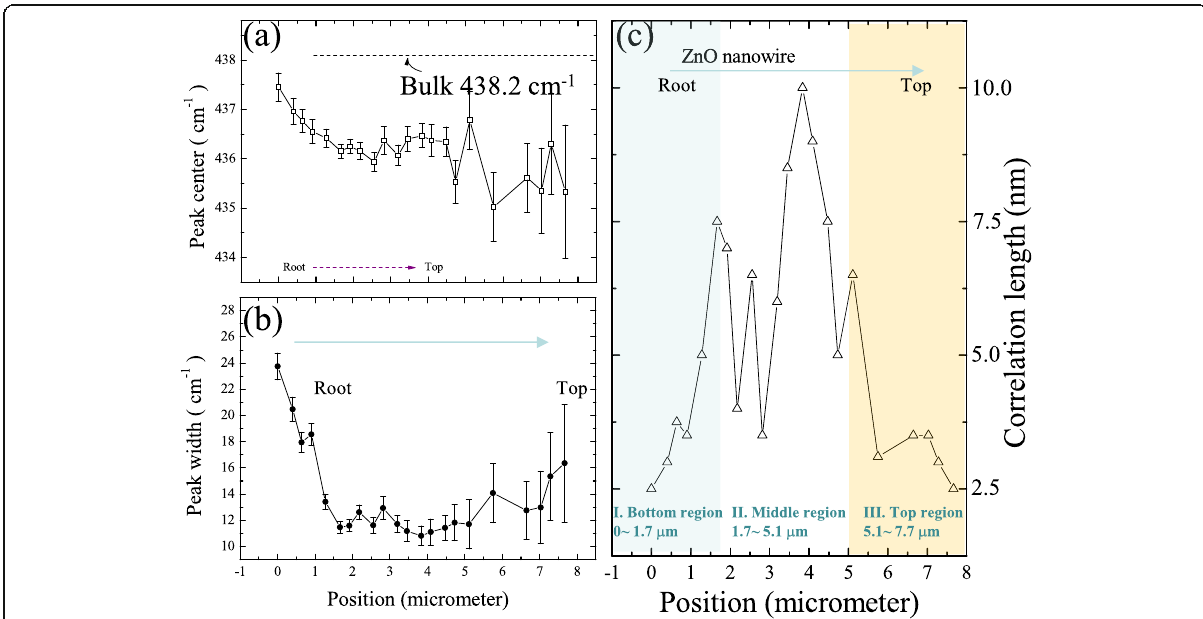
Fig. 4 a Peak positions, b widths, and c correlation lengths versus the nanowire length along the tip-like ZnO nanowire